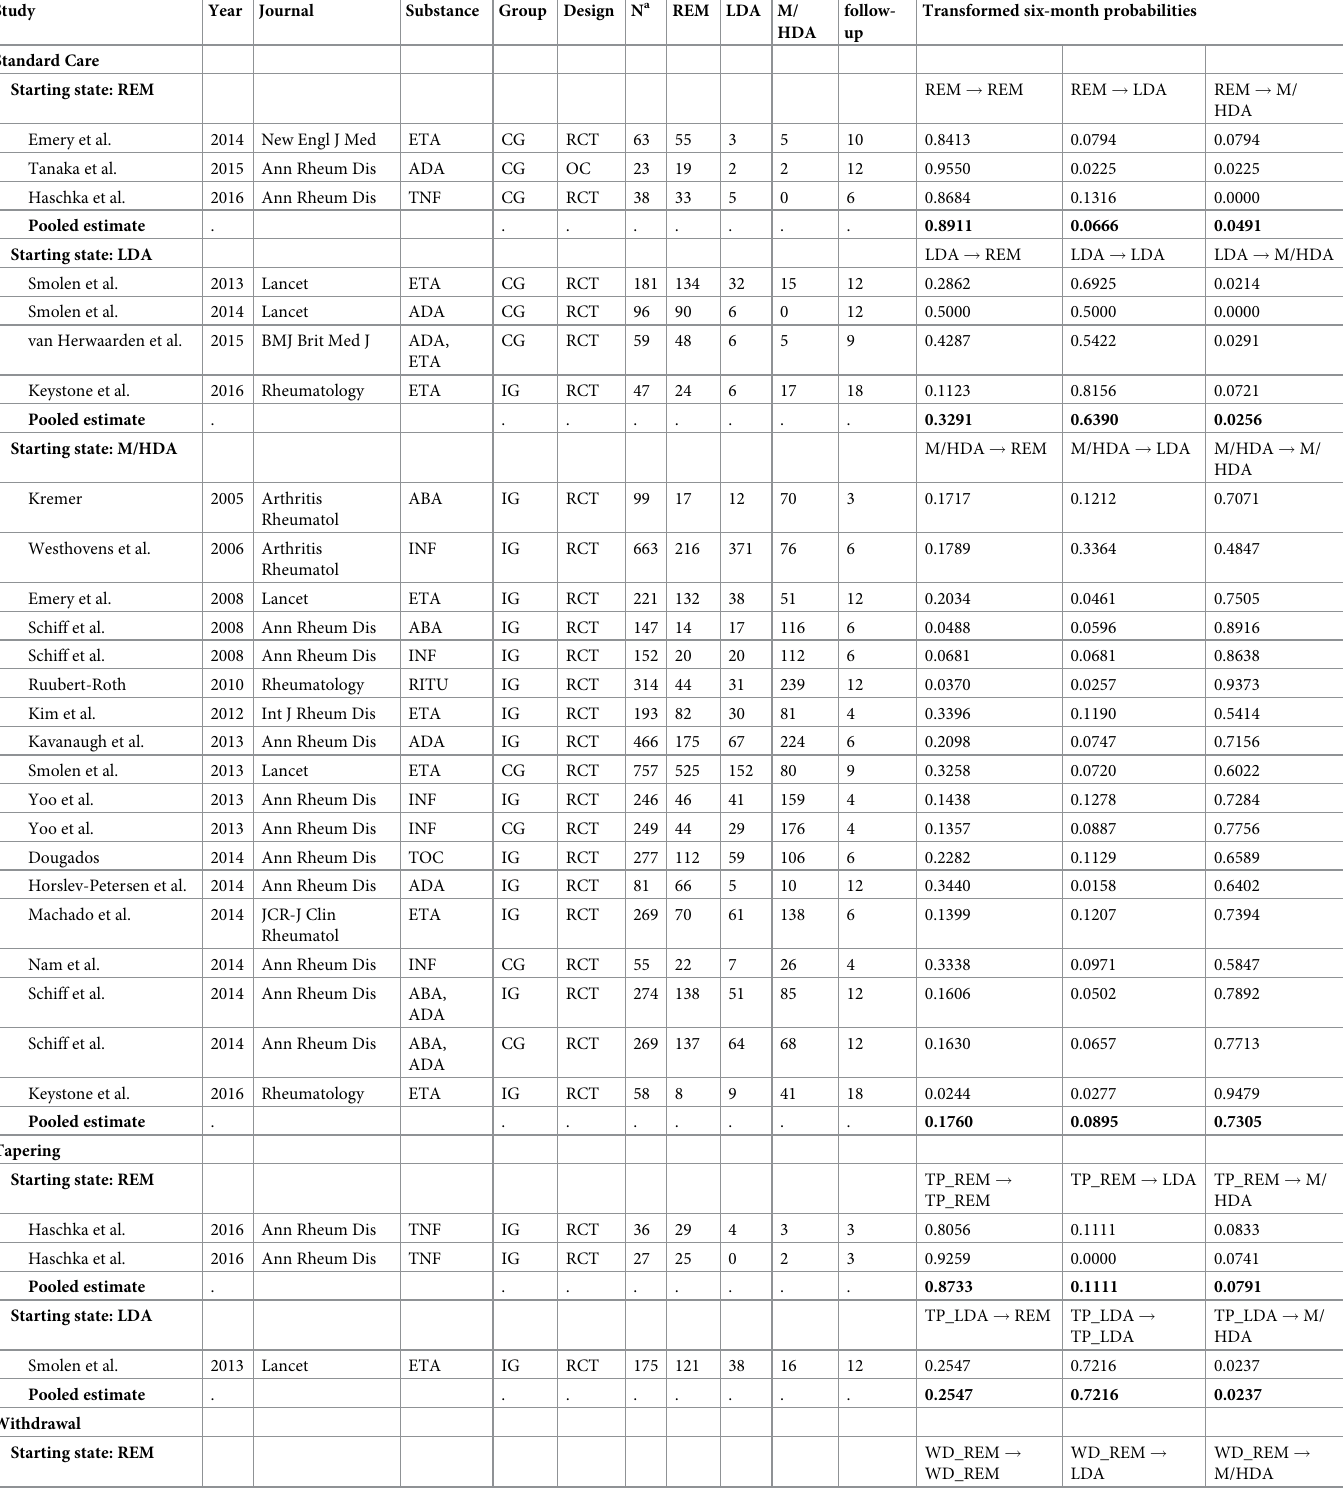
Table 1. Transition